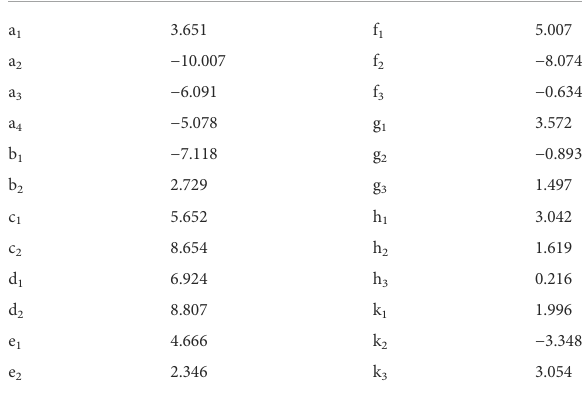
TABLE 4 Equation coef fi cient